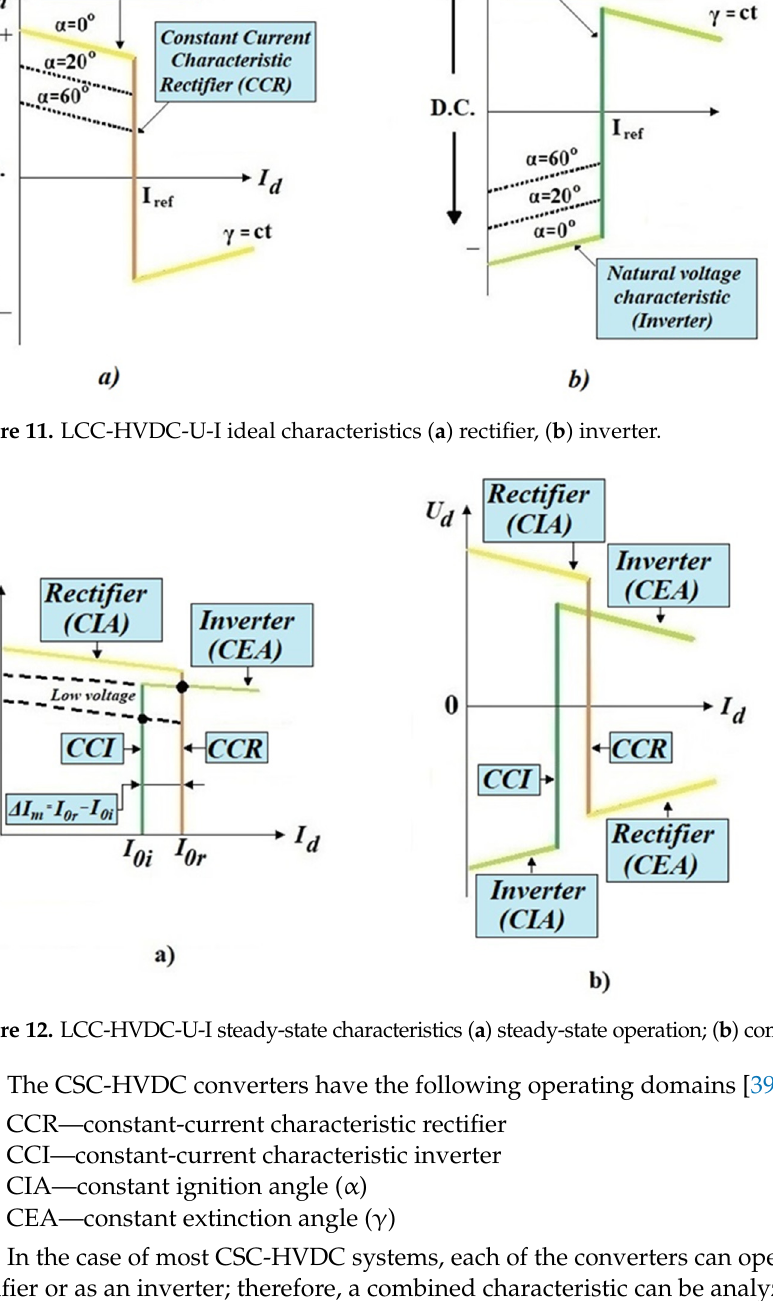
Energies 2022 , 15 , x FOR PEER REVIEW 12 of 29